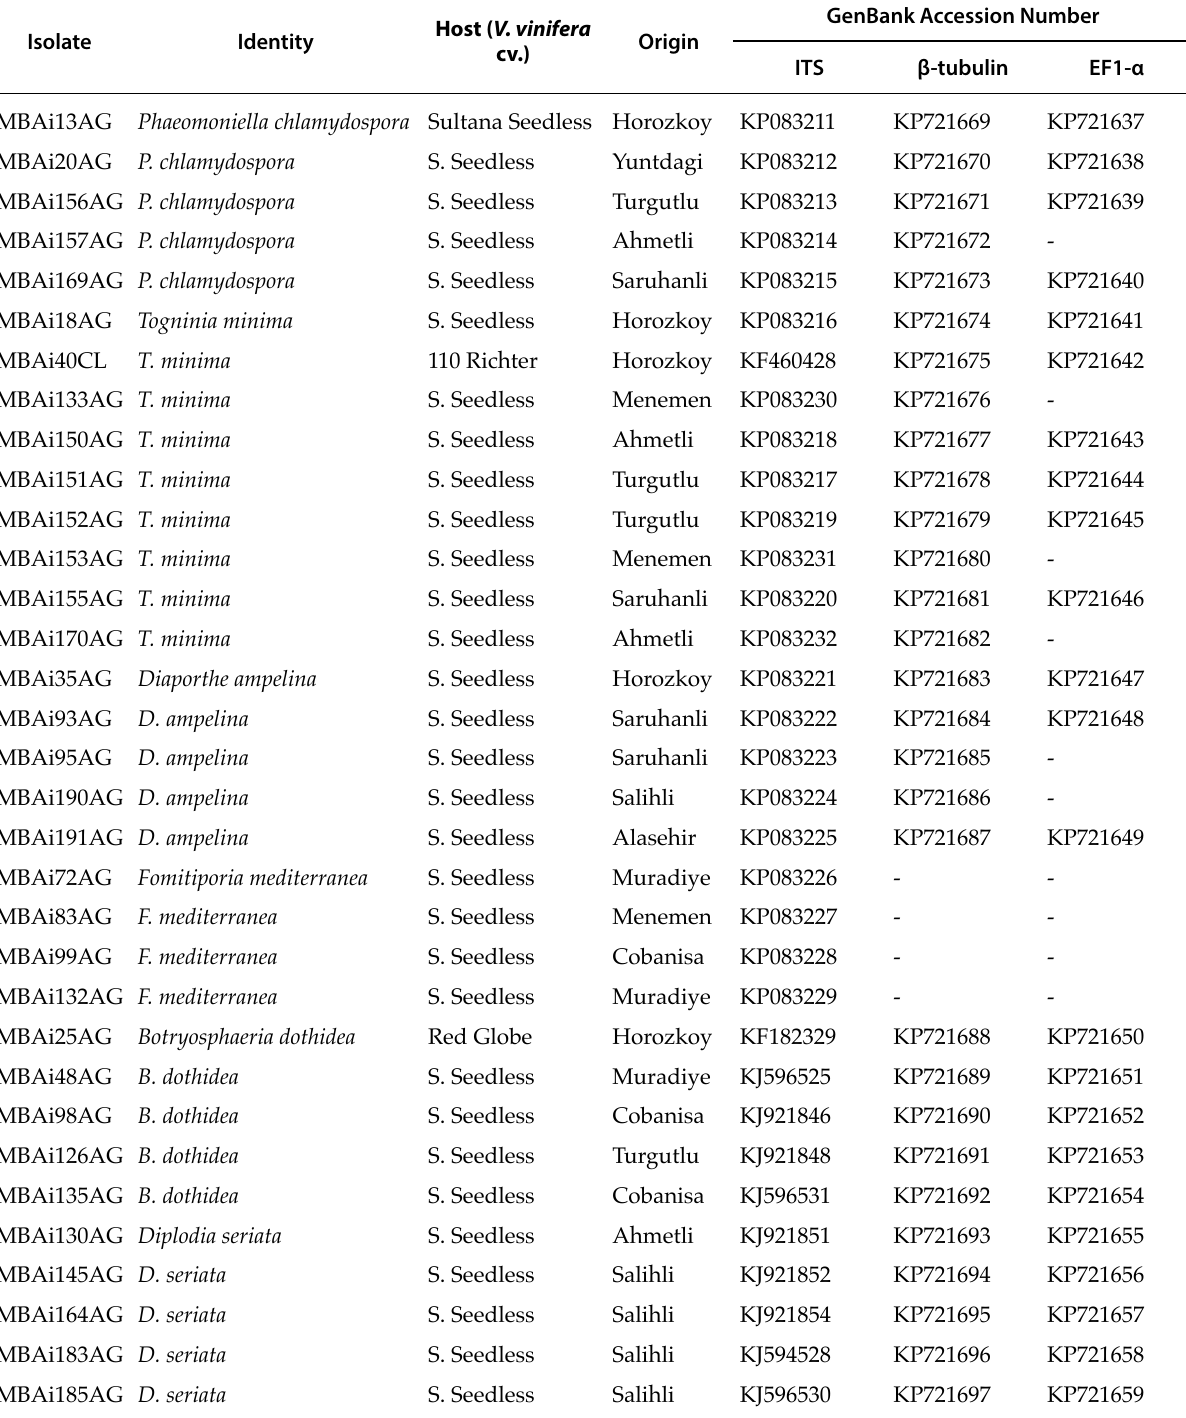
Table 3. GTD fungi from Sultana Seedless vineyards of the Aegean Region that were used in this study. Isolate